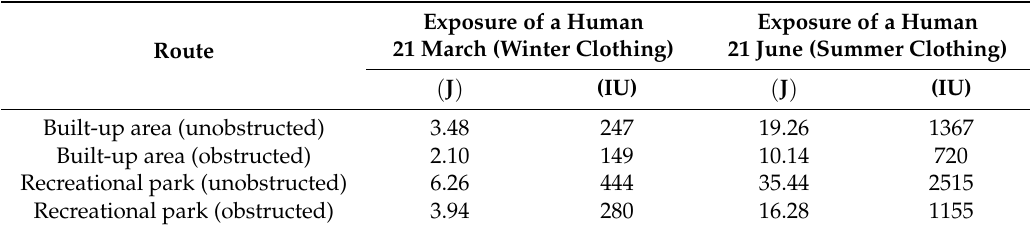
Figure 3. The vitamin D 3- weighted exposure of a human with winter clothing on 21 March at noon in front of the Institute of Meteorology and Climatology ( a ) and the university cafeteria ( b ) in normalized and absolute units. The human exposure depends on the orientation of the human model towards the sun. The total exposure (black line) is 25% ( a ) and 20% ( b ) smaller if the human is orientated with the face opposite to the sun (0°). The variation of the exposure by the diffuse part of the solar radiation of ( a ) is greater than of ( b ) due to a different distribution of the obstructions. The weighted radiance and the obstruction information of the locations are shown at the bottom of the plots (see also Equation (3) and Figure 2).